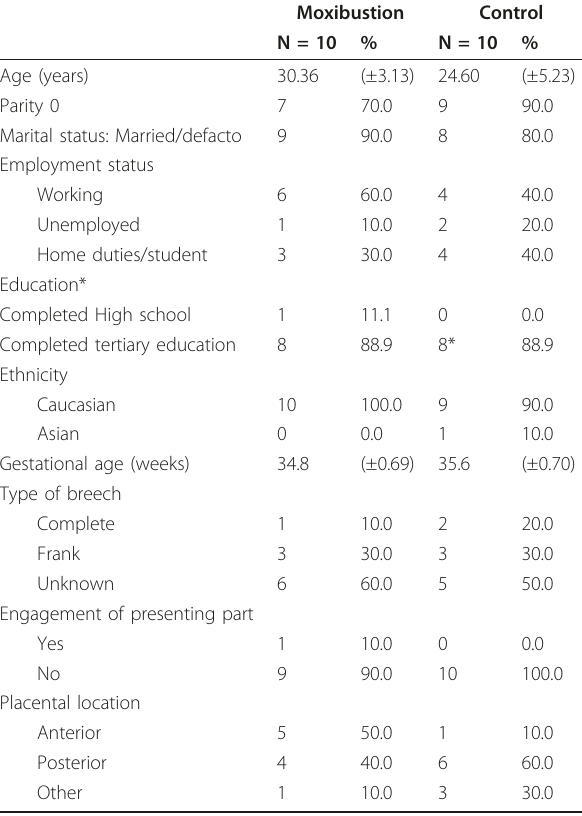
Table 1 Baseline characteristics of women at trial entry